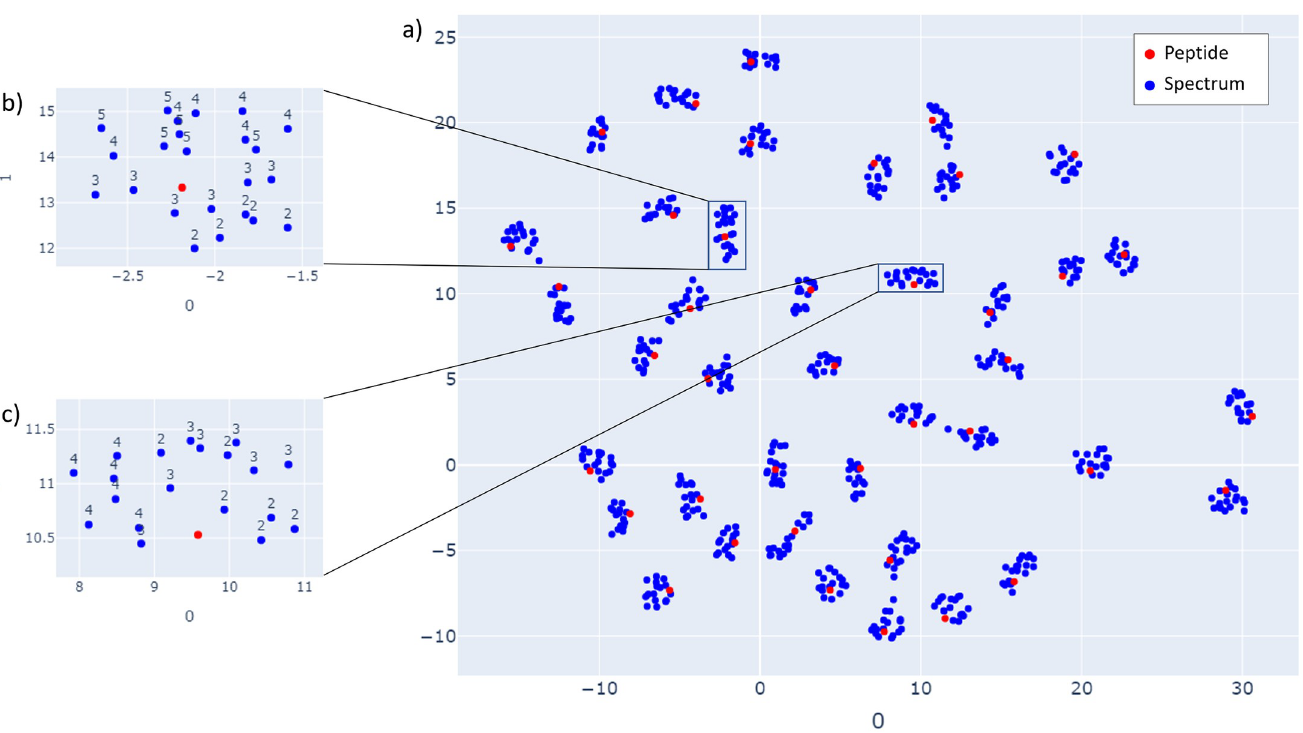
Fig 8. 2D UMAP visualization of embedded spectra and peptide vectors generated by SpeCollate. a) Clustering of spectra with different precursor charges around their corresponding peptides as well as the separation of clusters within a mass-range is shown for 40 unique peptides. The red point represents the peptide within a cluster, while the blue points represent spectra (with different charge values) corresponding to the peptide. Sub-figures b) and c) show the close-up of two clusters with charge labeling of spectra. As can be seen, spectra with all charges are mapped close to the peptide. However, spectra with higher precursor charge values are mapped relatively farther than those with smaller